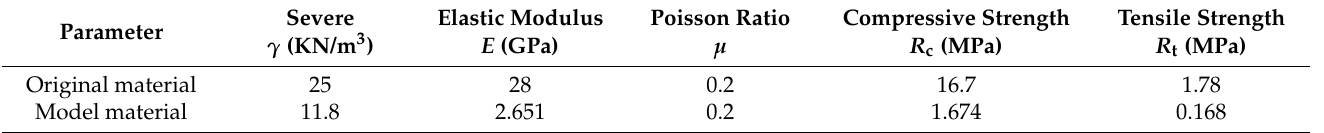
Table 1. Physical and mechanical indicators of lining.